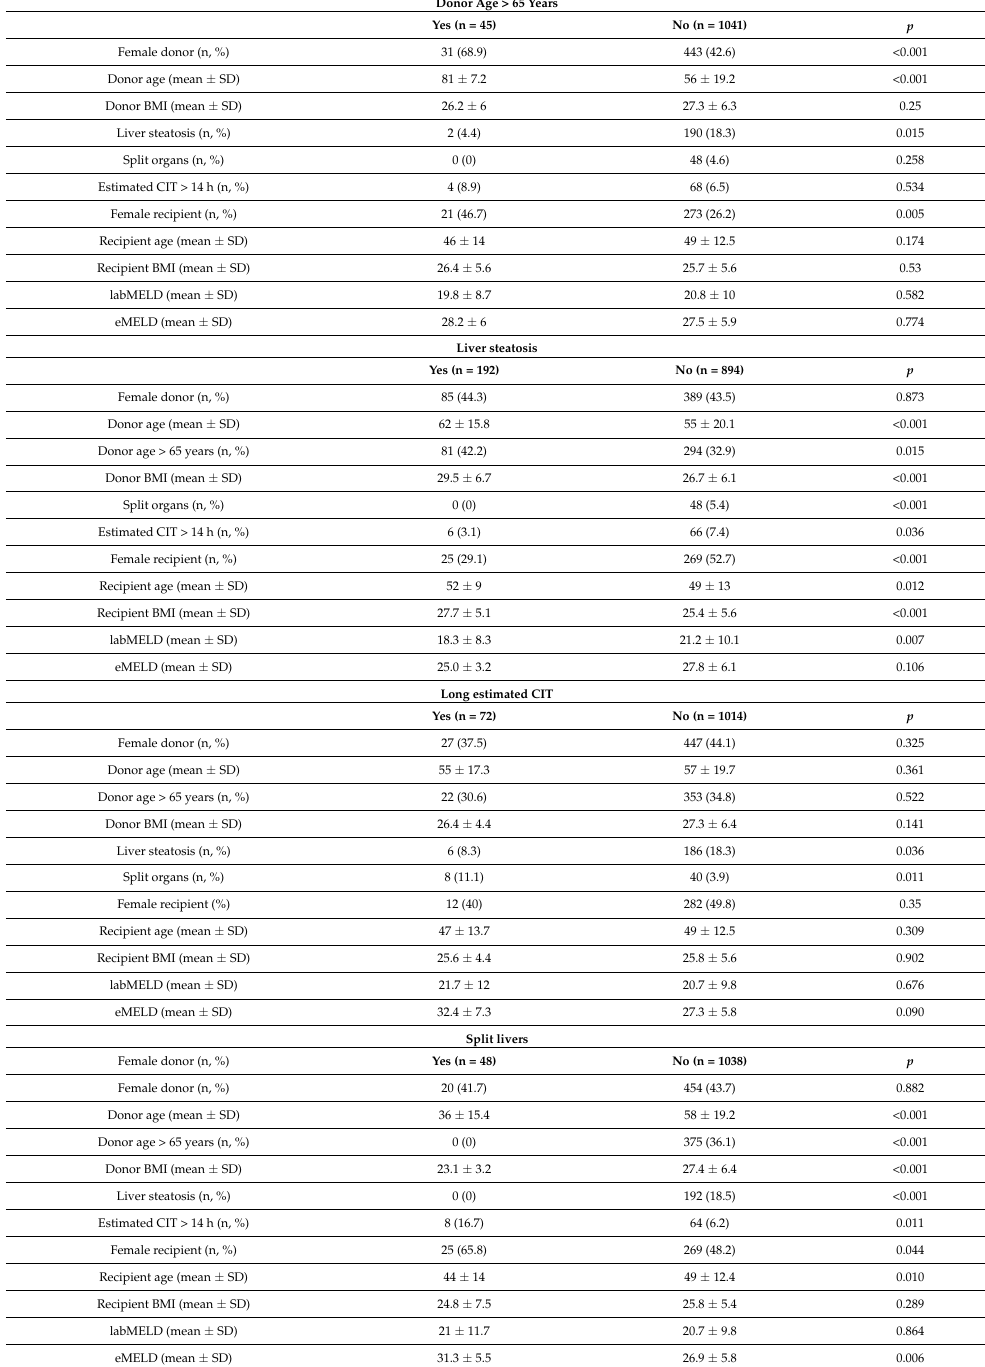
Table 2. Comparison of donor and recipient characteristics in cases of organs declined because of major extended donor criteria (maEDC) and organs declined for other